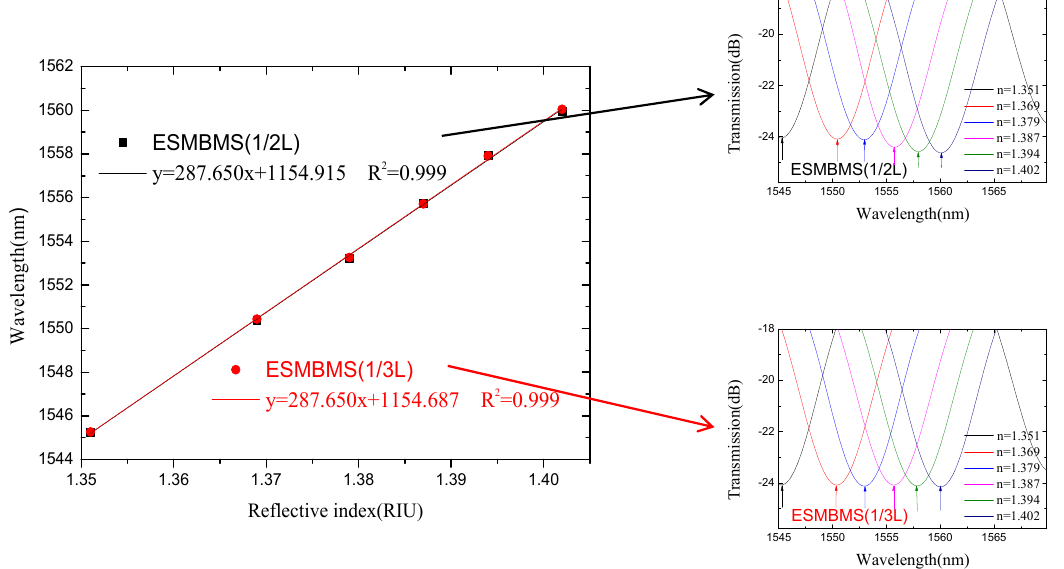
Figure 19. The sensitivity response characteristic diagram of ESMBMS MZI.